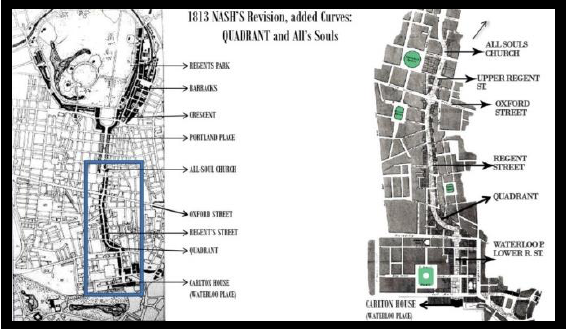
Figure 6: Nash’s second proposal in 1818 and the joints created by the